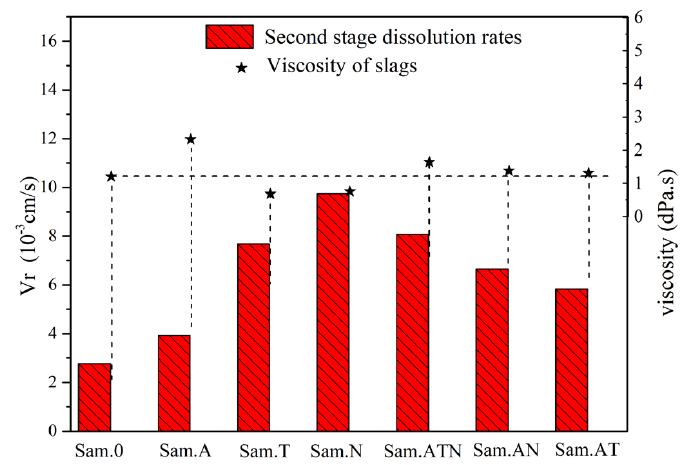
Figure 12. Dissolution rates of lime and viscosity in different slags in the second stage. In sample T with 10% TiO 2 , CaTiO 3 and CaSiTiO 5 are generated in the slag, which increases the diffusion coefficient k of CaO in slag. Additionally, the reduction in viscosity facilitates the mass transfer of CaO and promotes lime Compared with sample 0, after adding Al 2 O 3 , the MF boundary layer disappears in Sample A, which accelerates the dissolution of lime. However, the increase in viscosity caused by Al 2 O 3 impedes CaO diffusion in slag, eventually leading to only a slight in- crease in the lime dissolution rate.